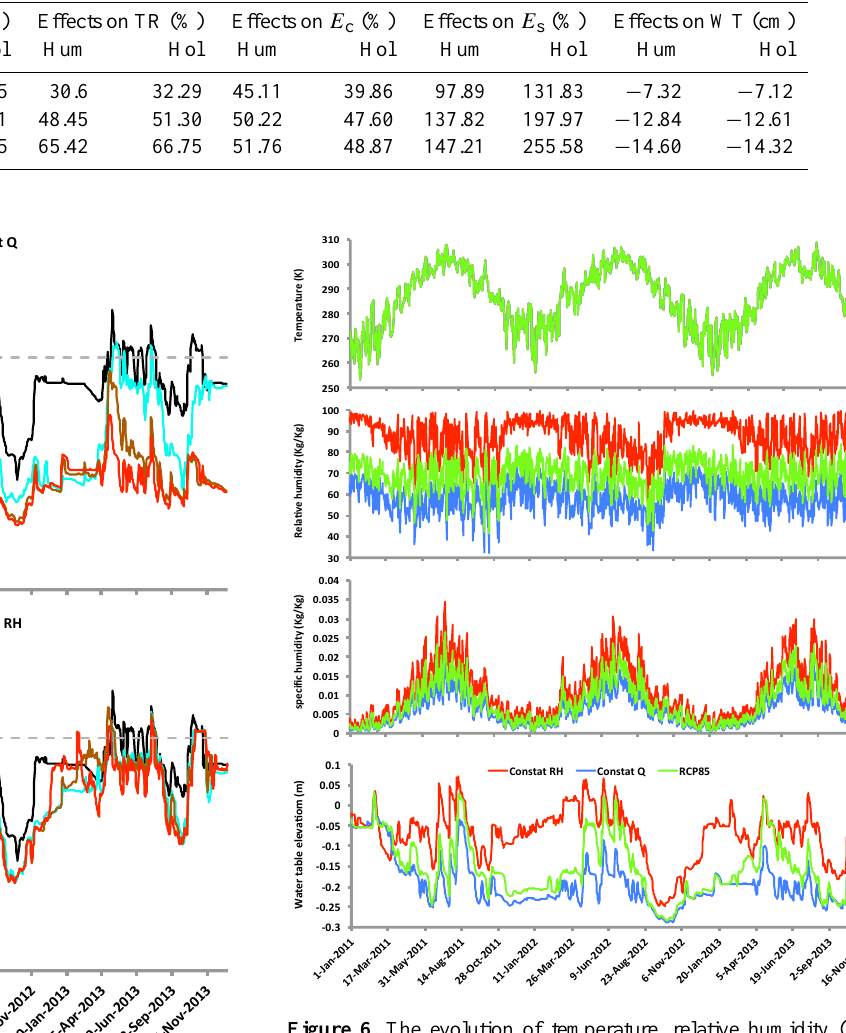
Figure 6. The evolution of temperature, relative humidity (RH), specific humidity ( Q ), and water table levels for warming ( + 9K) scenarios with three different humidity conditions: red lines desig- nate constant RH; blue lines designate constant Q ; green lines are for increasing Q 30% and decreasing RH 14% (RCP8.5 scenario) for years